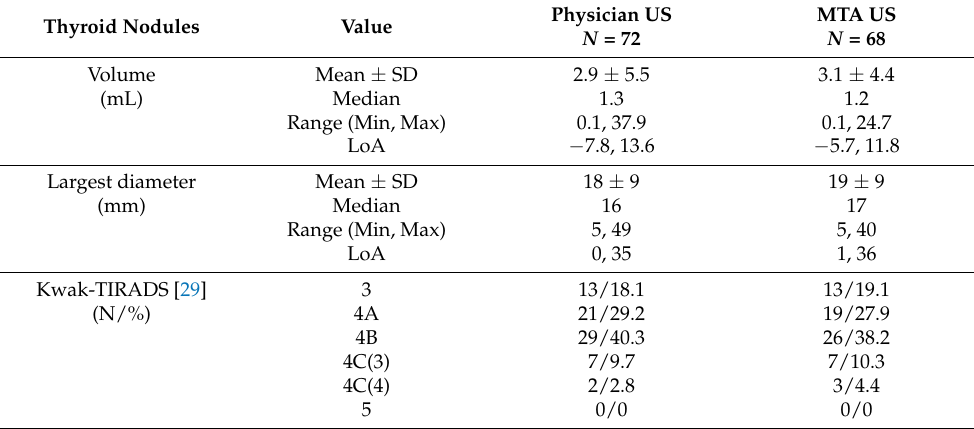
Table 2. Thyroid nodule (TN) size measurements and Kwak–TIRADS classifications [29] on conven- tional physician US and MTA US cine loop